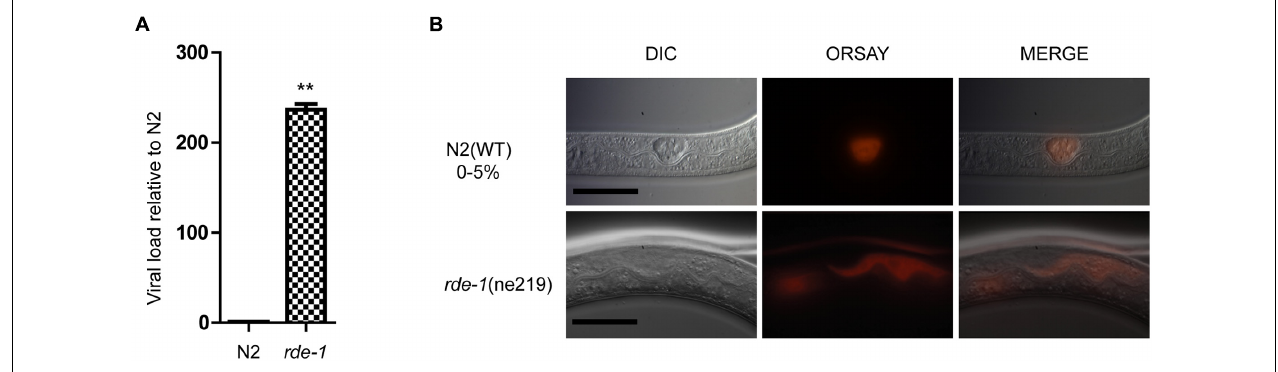
FIGURE 1 | Validation of Orsay virus replications in N2 and rde-1 ( ne219 ) mutant. (A) qRT-PCR analysis of viral loads after 4 days Orsay virus infection in N2 and rde-1 ( ne219 ). rde-1 ( ne219 ) mutant animals showed significantly higher levels of Orsay virus RNA compared to N2 animals do ( P < 0.01, t -test). (B) Fluorescence in situ hybridization (FISH) staining of Orsay viral RNA1 in Caenorhabditis elegans N2 and rde-1 ( ne219 ) mutant. Viral RNA1 were detected using Quasar R (cid:13) 670 labeled RNA FISH Probe corresponding to the RNA1 of Orsay virus. Red indicates the Orsay viral RNA and all scale bars represent 20 µ m.